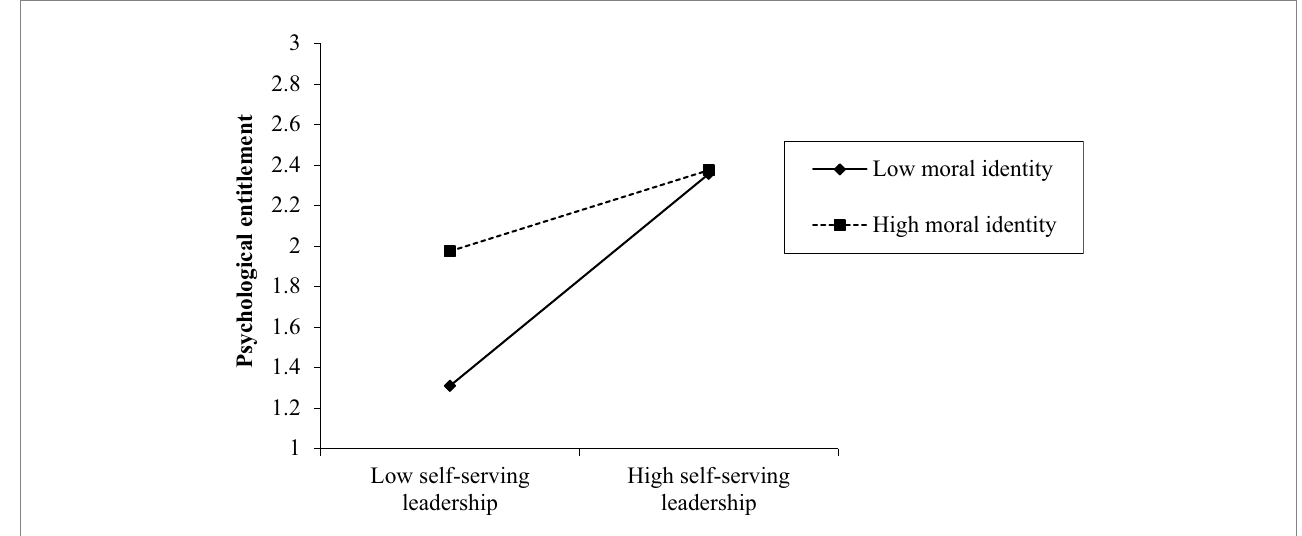
FIGURE 2 The moderating effect of moral identity on the relationship between self-serving leadership and psychological entitlement.